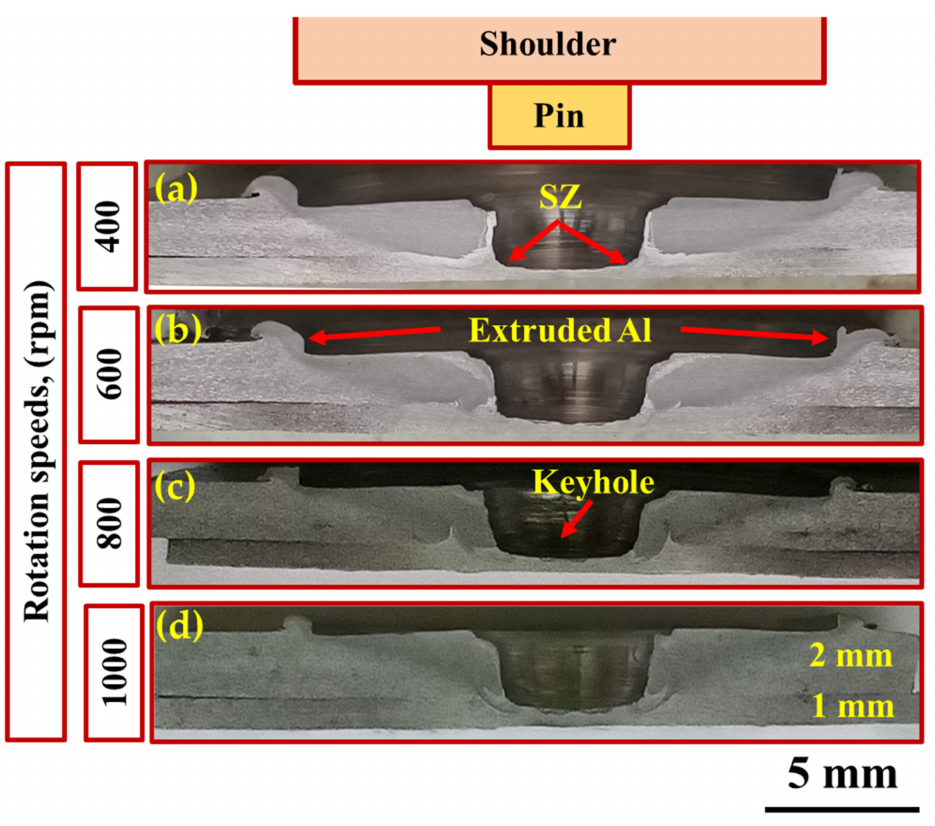
Figure 8. Macrographs of the transverse cross-section of the FSSW lap joints at a constant dwell time